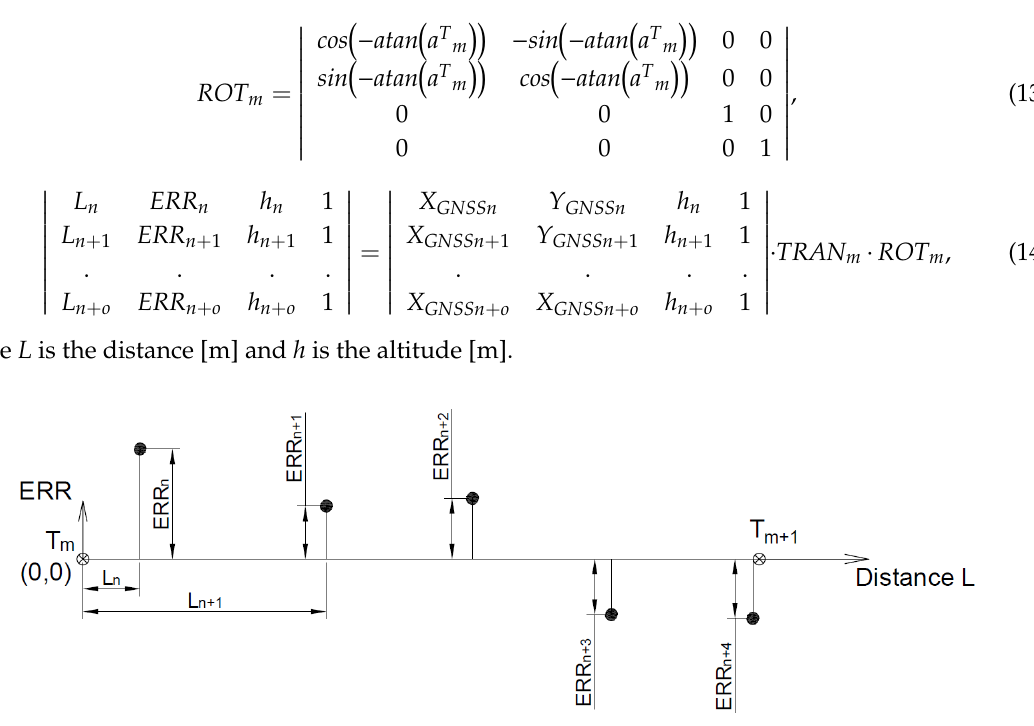
Figure 12. Schematic diagram of the calculation of the distribution of the residuals: Surveying-kinematics GNSS.